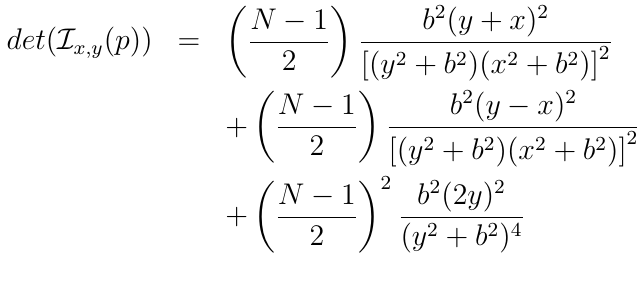
Figure 3. Localization with N number of AoA